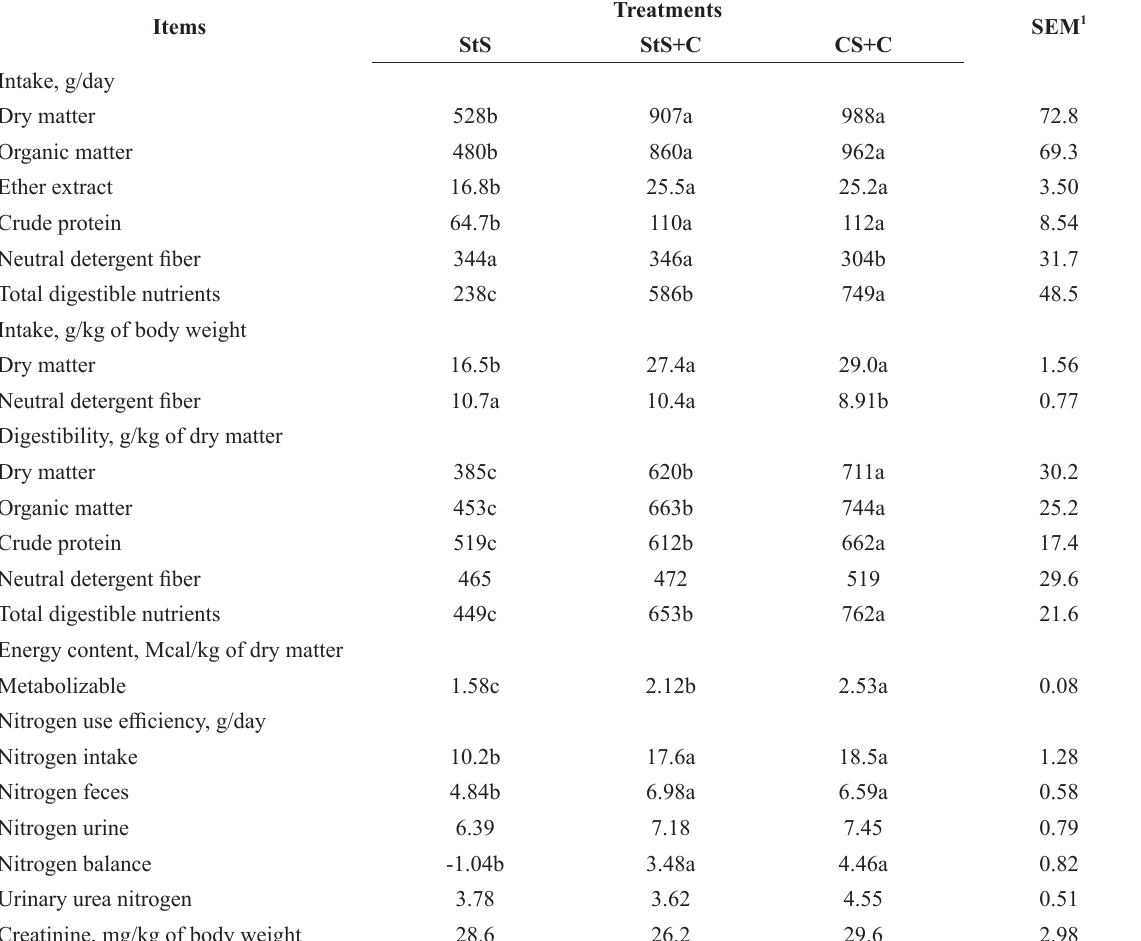
Nutrient intake, total apparent digestibility, and nitrogen efficiency of sheep fed Stylosanthes silage without